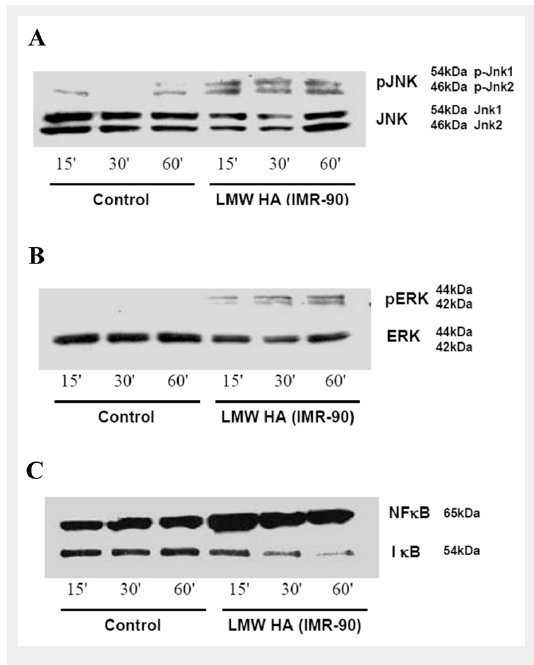
Figure 3 LMW-HA from stretched foetal lung fibroblasts (IMR 90 cells) activated the JNK, ERK, and NF-κB/IκB pathways in human BEAS-2B bronchial epithelial cells. Western blot analysis: A. c-jun N-terminal kinase; B. ERK-1 and ERK-2; and C. NFκB in nuclear fraction/ IκB in cytosolic fraction. Each blot is representative of 3 separate experiments.